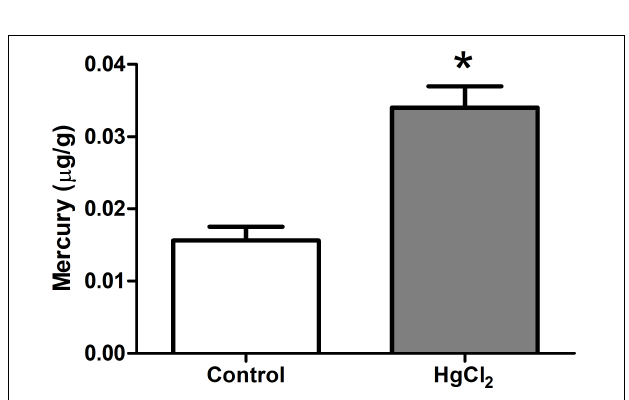
FIGURE 4 | Effects of chronic exposure to HgCl 2 on the formation of mercury deposits in the brain parenchyma in the motor cortex of adult Wistar rats. Results are expressed as mean ± standard error. ∗ p < 0.05 compared to the control group (Student’s t -test).